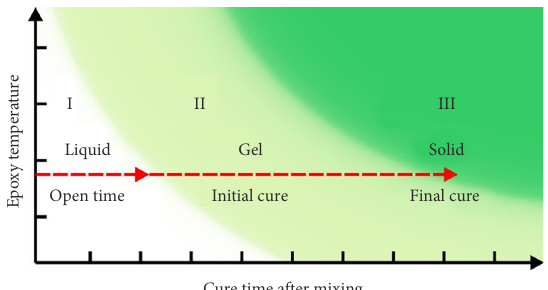
Cure time after Figure 3. Curing stages of epoxy oligomer (Hou et al. 2013)